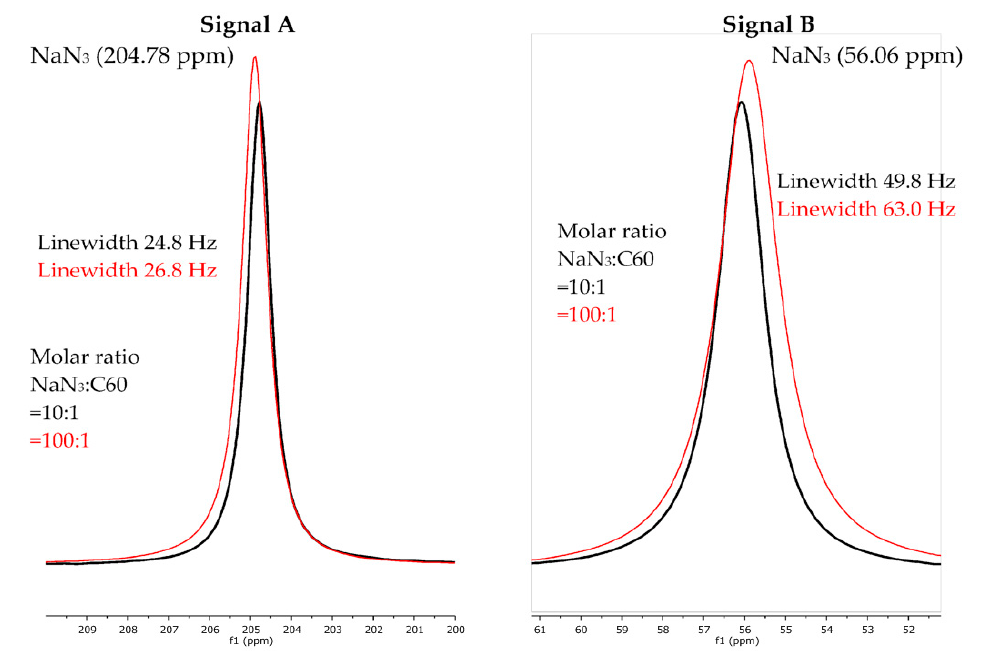
Figure 4. Superimposition of two spectra at a high ratio of NaN 3 :C60 (>10:1), specifically 100:1. There are some subtle changes in the 14 N chemical shift and line-width of both NaN 3 peaks (Signals A and B ).